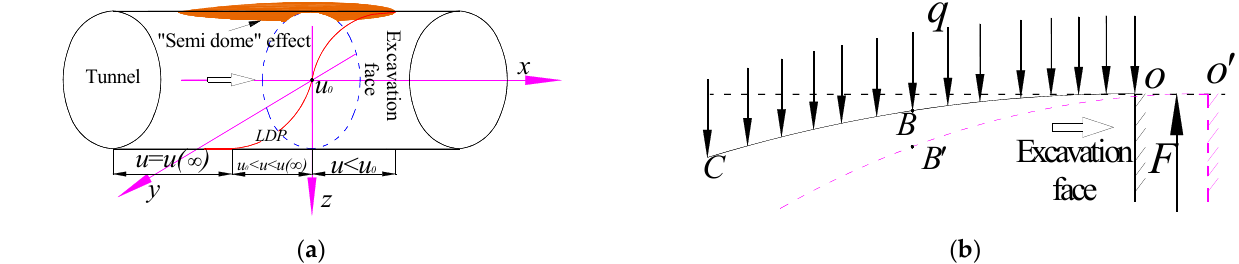
Figure 1. Schematic diagram of spatial effect of excavation face: ( a ) Semi dome effect; ( b ) Cantilever beam assumption of excavation face.